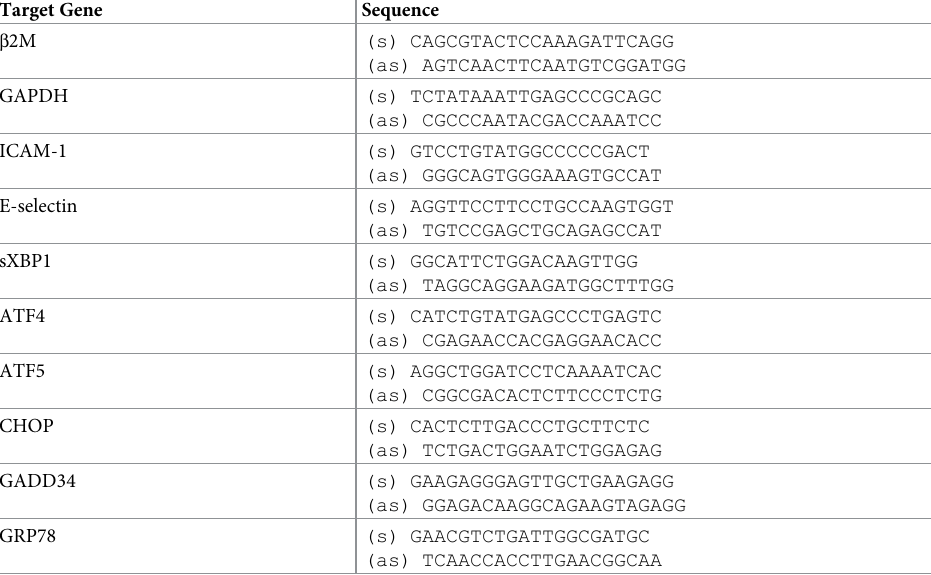
Table 1. Sequence of RT-qPCR